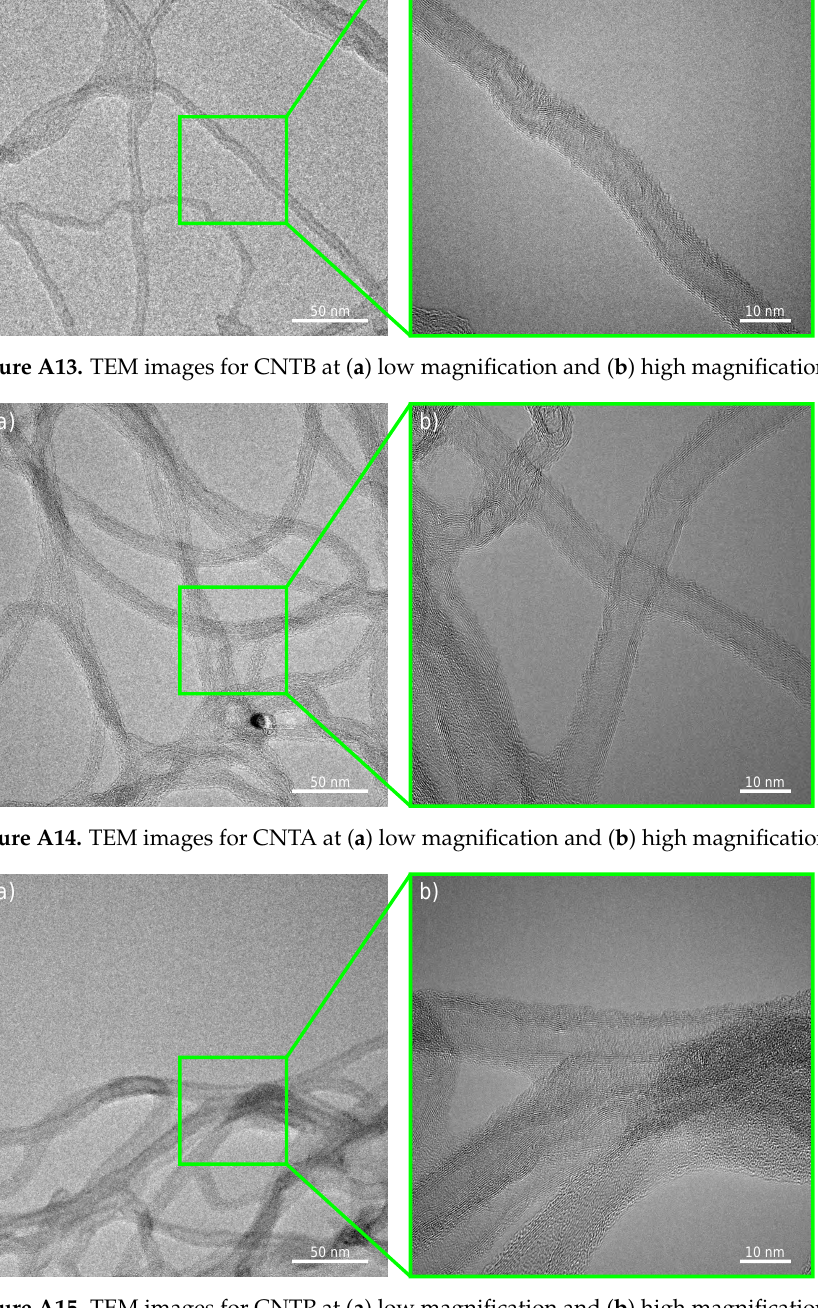
Figure A15. TEM images for CNTP at ( a ) low magnification and ( b ) high magnification. Figure A16 gives the TEM images of CNTN. The elastomer is clearly visible and the MWCNT are well incorporated into the